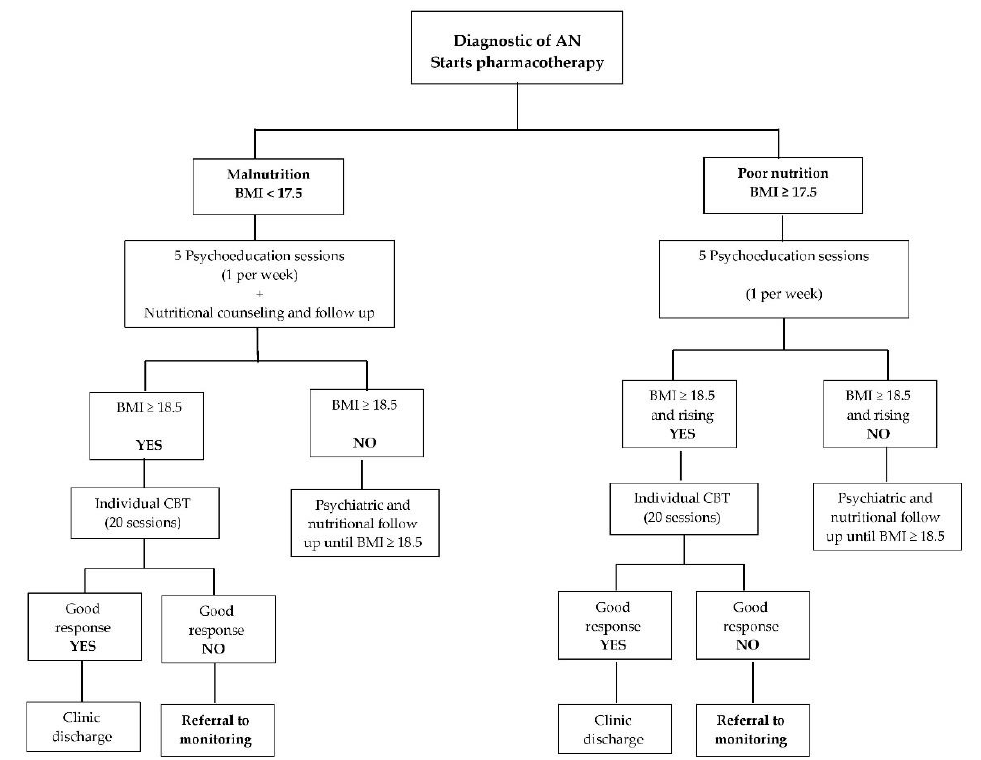
Figure 1. Algorithm of treatment for AN used at the CED. Time elapsed from admission to the clinic to referral to monitoring, varies depending on each patient’s individual response, number of relapses, and adherence to treatment.